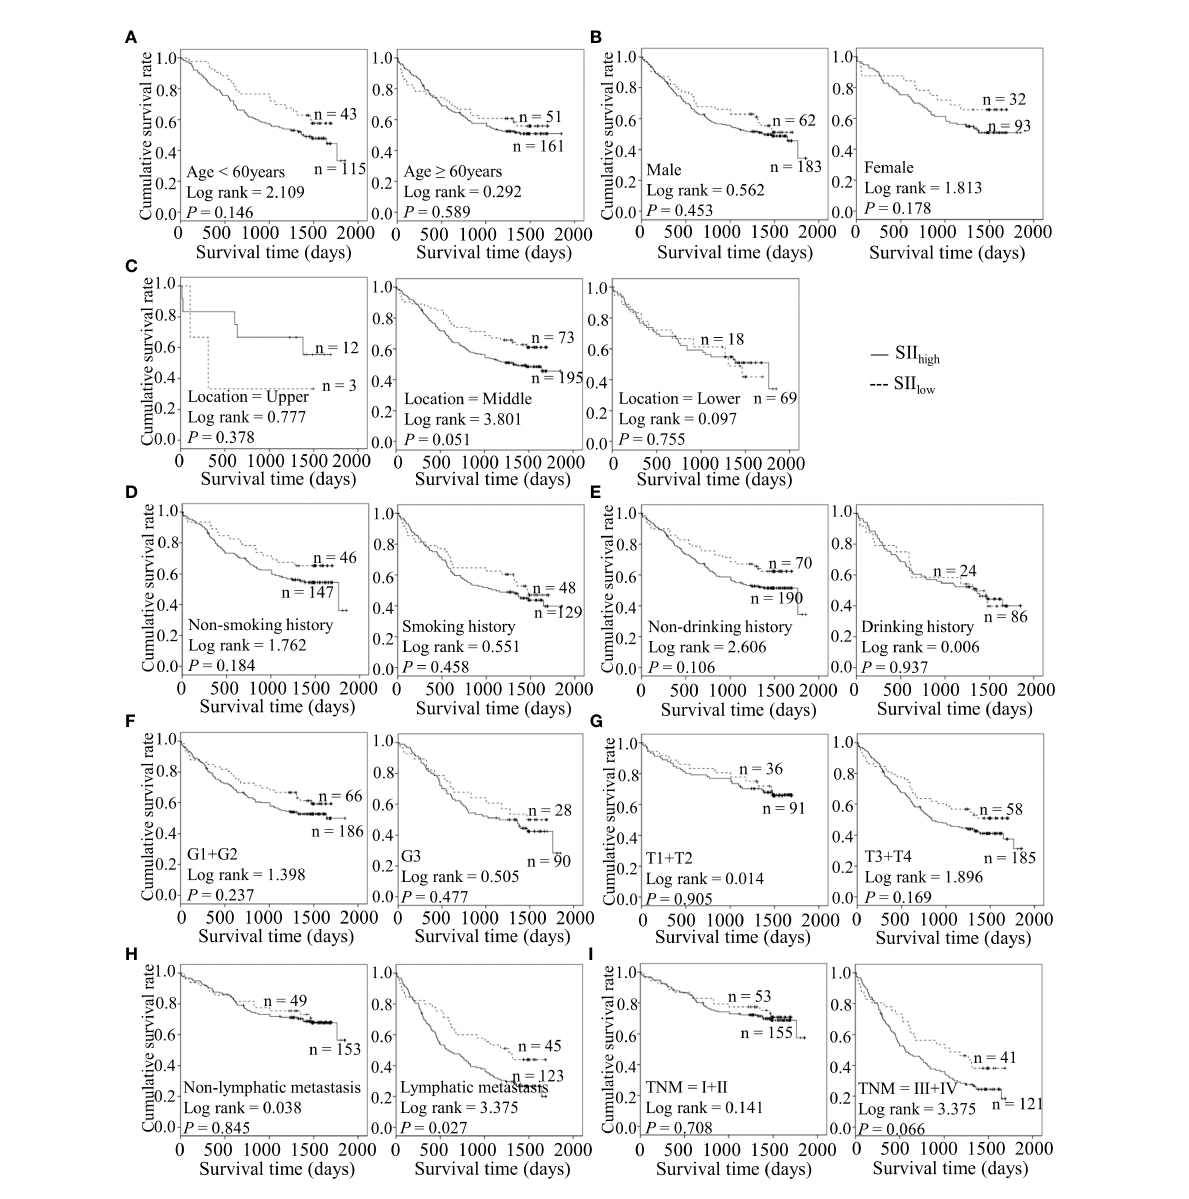
FIGURE 2 Predicating role of preoperative SII level for the OS of ESCC patients. (A – I) Kaplan-Meier survival curves of ESCC patients with different SII levels combined with diverse features like age (A) , gender (B) , tumor location (C) , smoking history (D) , drinking history (E) , tumor grade (F) , T stage (G) , lymph node metastasis (H) and TNM staging (I)